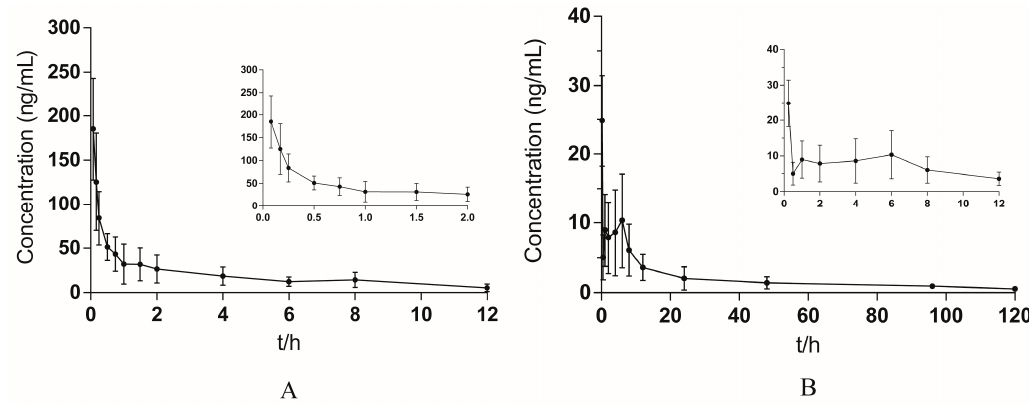
Figure 2. Mean plasma concentration-time curves of yuanhuacine after intravenous ( A ) and pulmonary ( B ) administration. The results revealed that the effects of yuanhuacine through pulmonary administration compared to intravenous injection could last for a longer time. Table 4. Pharmacokinetic parameters of yuanhuacine in rats after intravenous and pulmonary administration ( n = 5).